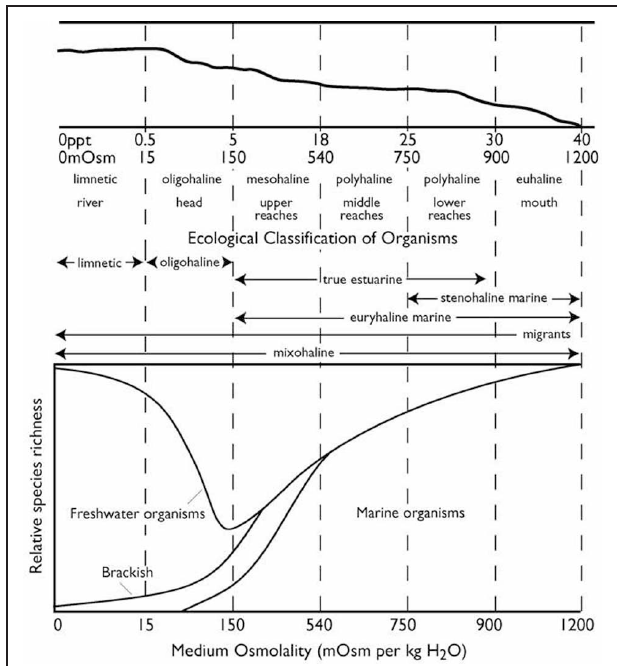
FIGURE 1 | Schematic representation of a typical coastal plain estuary. Top panel : longitudinal profile of the estuary; the solid sloping line represents the division between the water column above and the sediment below. The longitudinal salinity gradient of the estuary runs from riverine fresh water of 0ppt salinity at the far left to full-strength seawater of up to 40ppt salinity at the far right. Salinity is also shown as mosm kg − 1 water. Specific zones of the estuary are based on annual salinity variation. Middle panel : ecological classification of the distributions of organisms that spend either part or all their life cycle along the salinity gradient of the estuary. Physical and ecological classification based on the “Venice” system of Carriker (1967). Bottom panel : relative species richness (number of species) of different ecological classifications found across the salinity zones of the estuary [redrawn from Gainey and Greenberg (1977), for the distribution of benthic marine and estuarine